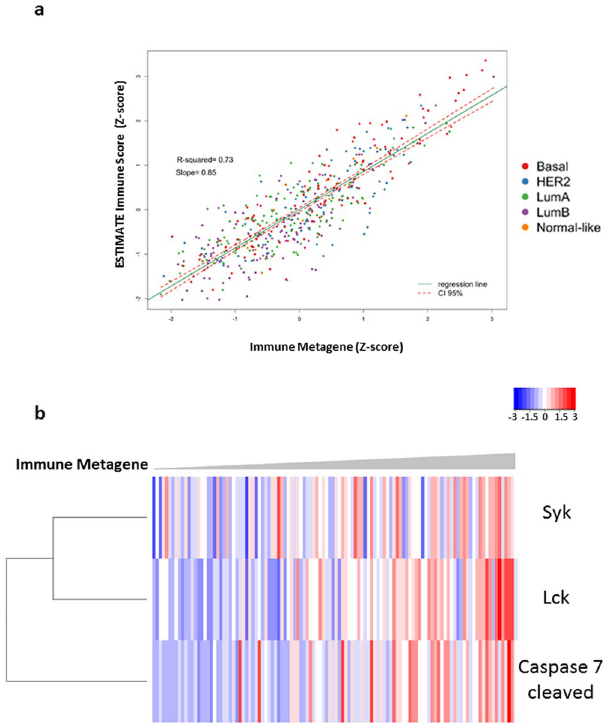
Figure 4. Expression of the immune module in TCGA-BRCA dataset is related to an increase in immune cells and in proteins necessary to an active immune response. ( a ) – Pearson Correlation between the ESTIMATE Immune score and the Immune metagene in the TCGA-BRCA dataset, r 2 = 0.73, p < 0.01. ( b ) – Heatmap representing a semi-supervised clusterization of the protein levels of SYK, LCK and cleaved Caspase 7 in TCGA-BRCA dataset ordered by the rank of the Immune metagene. The correlation of the proteins level with the Immune metagene for SYK is r = 0.41, for Lck is r = 0.51 and for cleaved Caspase 7 r = 0.51. p < 0.01. Immune metagene = Metagene formed by the expression of IKZF3, SCML4, SP140 and